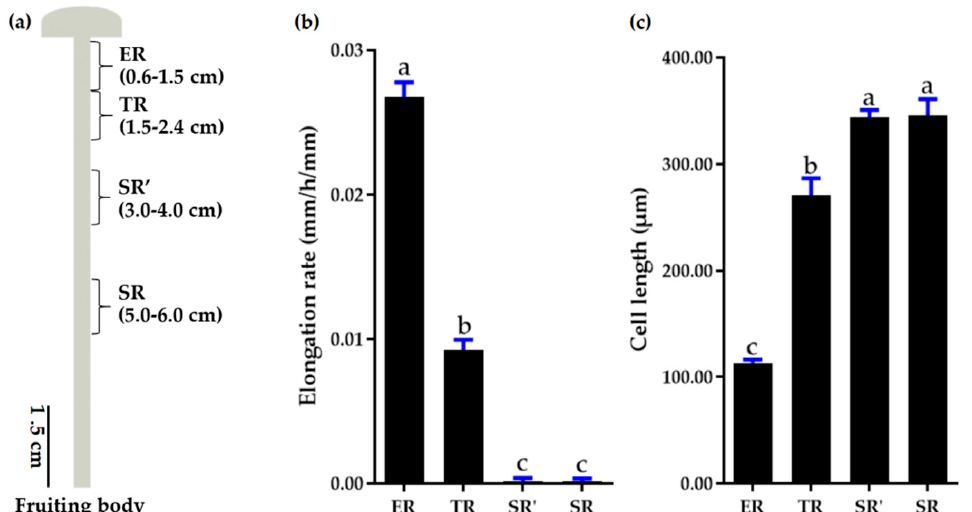
Figure 1. Stipe gradient elongation features of F. filiformis . ( a ) Stipe regions. ER, elongation region; TR, transition region; SR’ and SR, stable regions. ( b ) Elongation rate of different regions ( n = 15). ( c ) Cell length of different regions ( n = 4; value of each sample was average length of 50 cells). Different letters over columns denote significant differences ( p < 0.05, paired t test).